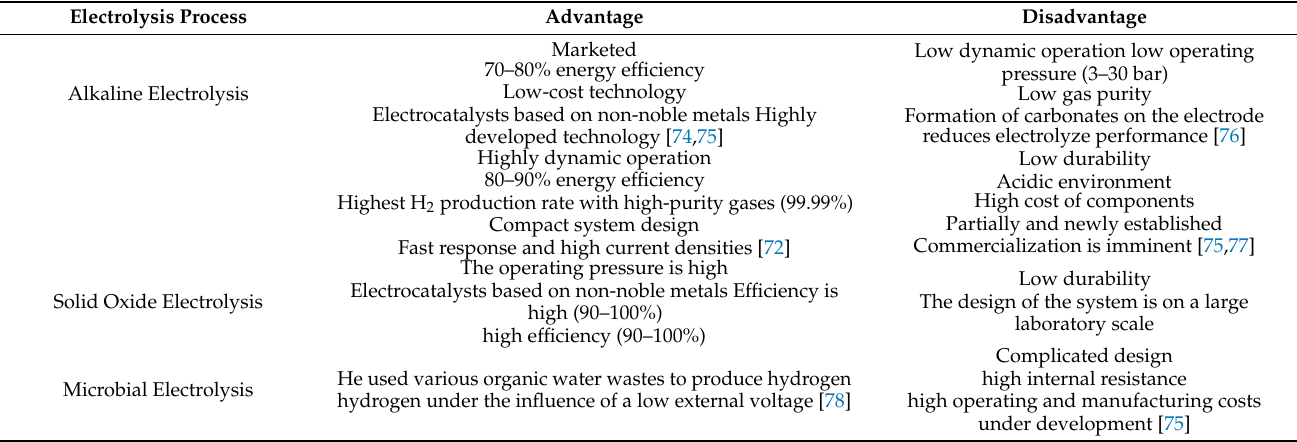
Table 9. Description of the electrolysis